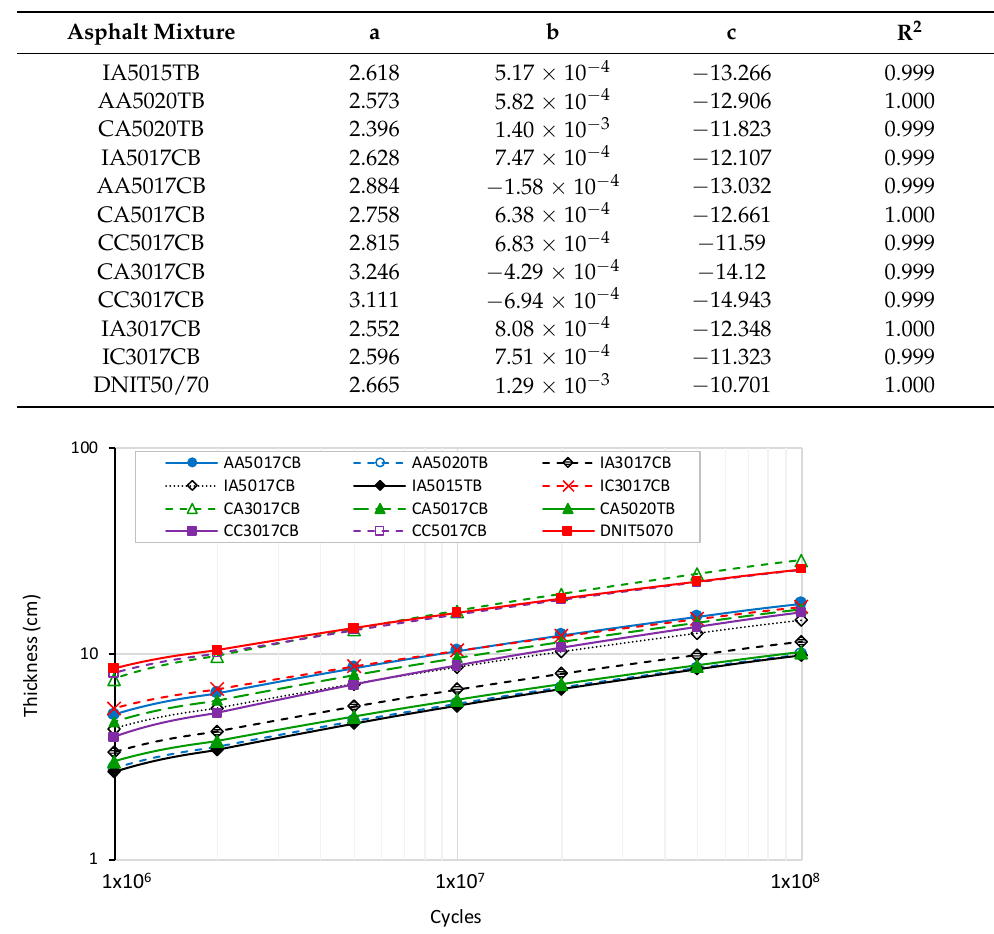
Figure 10. Required thickness of each mixture for pavement design.